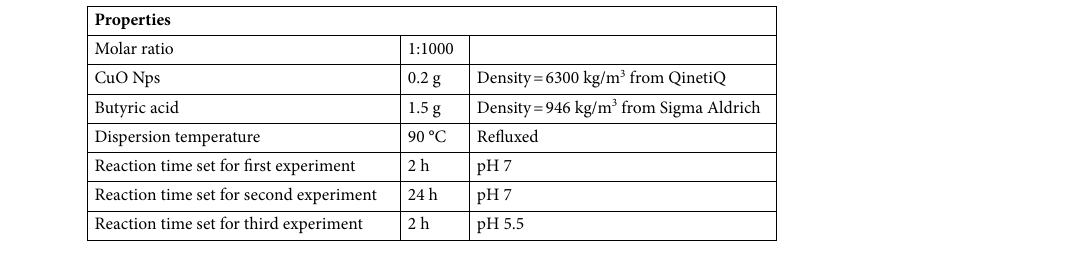
Table 1. Nanofluid and surfactant